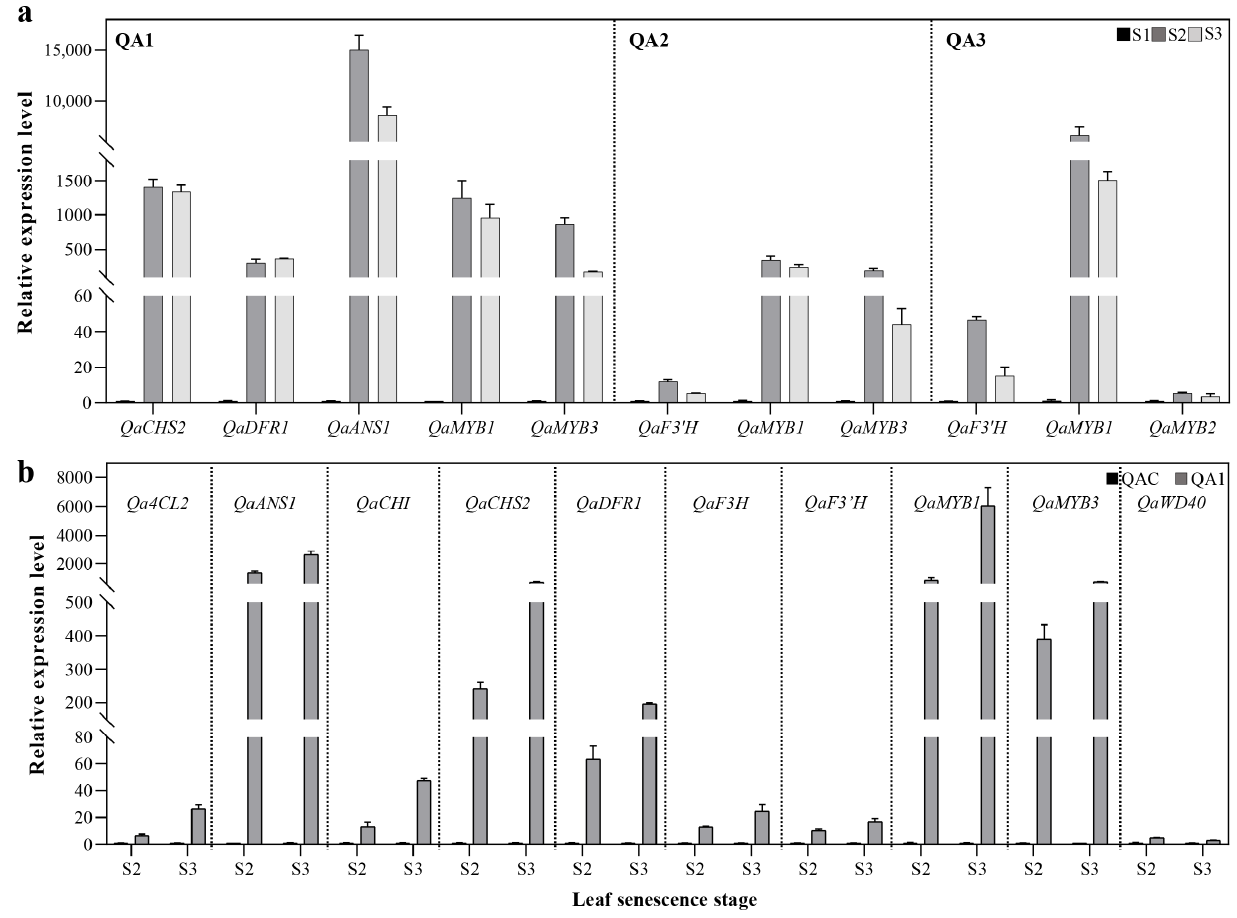
Figure 4. Expression of selected genes based on quantitative PCR. ( a ) Comparison of genes ex- pressed in QA1, QA2, and QA3 during senescence (S1–S3); ( b ) comparison between QAC and QA1 at S2 and S3. Bars represent standard deviation (SD, n = 3).